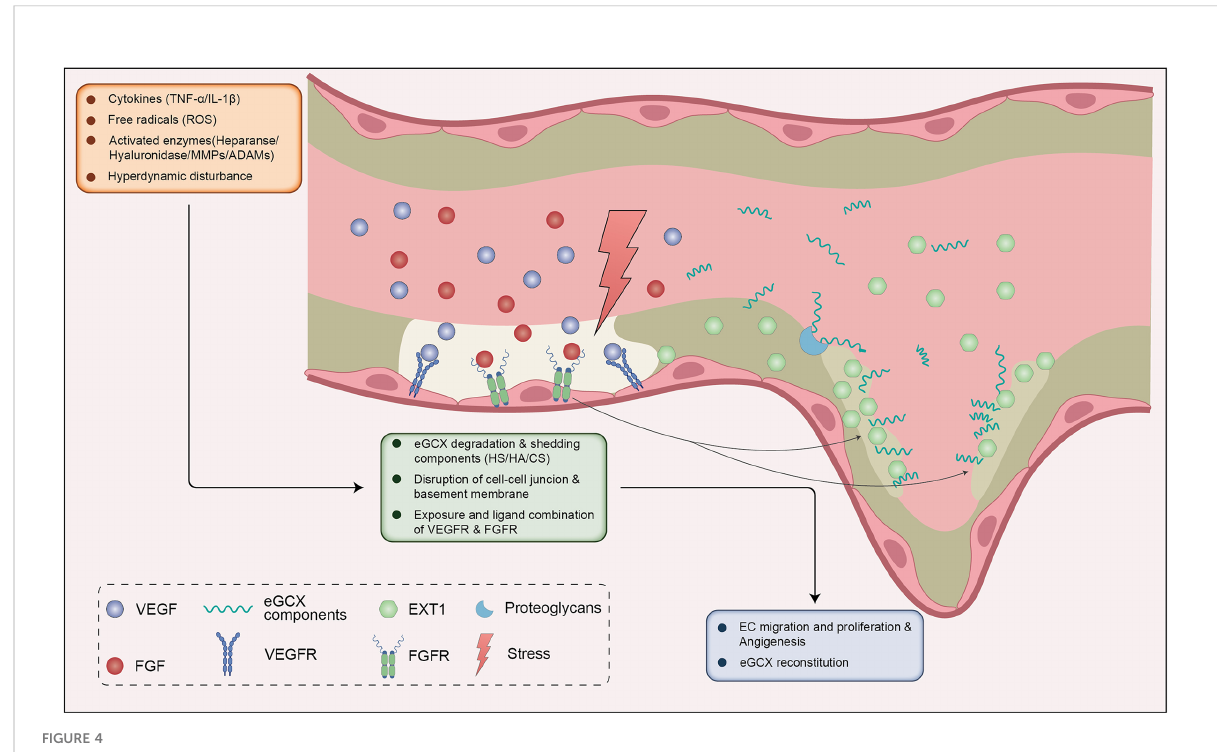
FIGURE 4 eGCX may be involved in HPS associated angiogenesis. During HPS, eGCX degradation also leads to exposure of VEGFR and FGFR, ensuing the combination of VEGF and FGF respectively. VEGF-VEGFR and FGF-FGFR signals promote the migration and proliferation of ECs. The disruption of eGCX continuity promotes the destruction of cell-cell junctions and the basement membrane, which together with ECs proliferation and migration facilitates the sprout of neovessel. The FGF-FGFR signal activates the downstream enzyme EXT1 to reconstitute the eGCX layer within the injured site and neovessels (in the dashed line frame). The shedded eGCX components are absorbed by the proteoglycans on the EC membrane and enhance the reconstitution of eGCX. Abbreviations: eGCX, endothelial glycocalyx; HS, heparin sulfate; HA, hyaluronic acid; CS, chondroitin sulfate; VEGFR, vascular endothelial growth factor receptor; FGFR, fi broblast growth factor receptor; ROS, reactive oxygen species; TNF- a , tumor necrosis factor a ; IL-1 b , interleukin-1 b ; MMPs, matrix metalloproteinases; ADAMs, a disintegrin and metalloproteinases; EXT1, exostosin 1; EC, endothelial